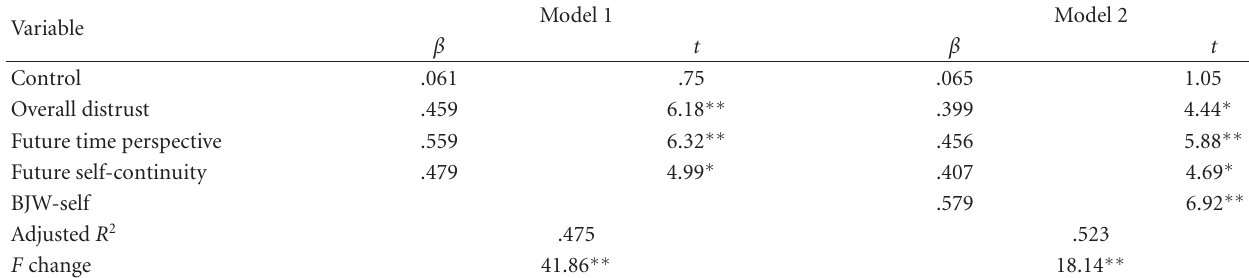
Table 4: Hierarchical regression analysis ( N = 440) showing ability of BJW-self to predict mortality over and above control, interpersonal and society distrust, future time perspective, and future self-continuity perspective.